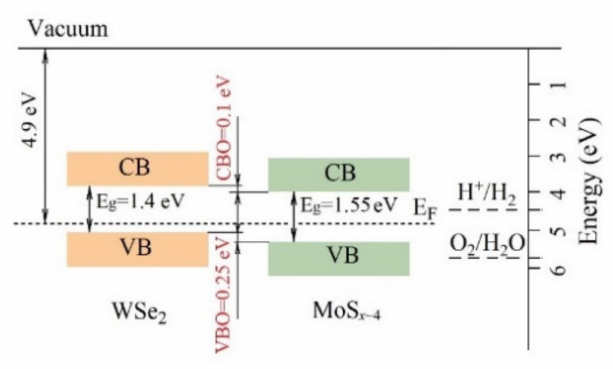
Figure 14. Band alignment diagram for the MoS x ~4 /WSe 2 heterojunction system obtained by